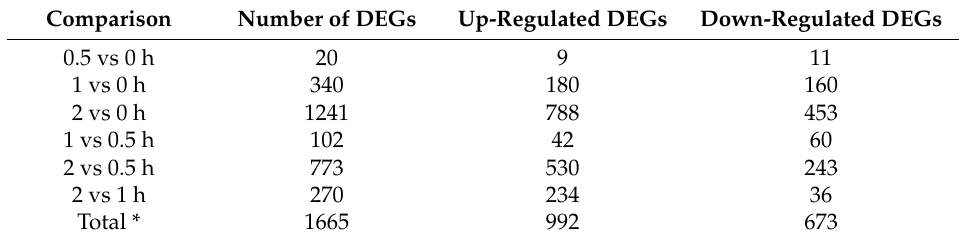
Table 1. Differentially expressed genes that were specifically up-regulated or down-regulated by PEG drought stress in potato genotype P3-198.